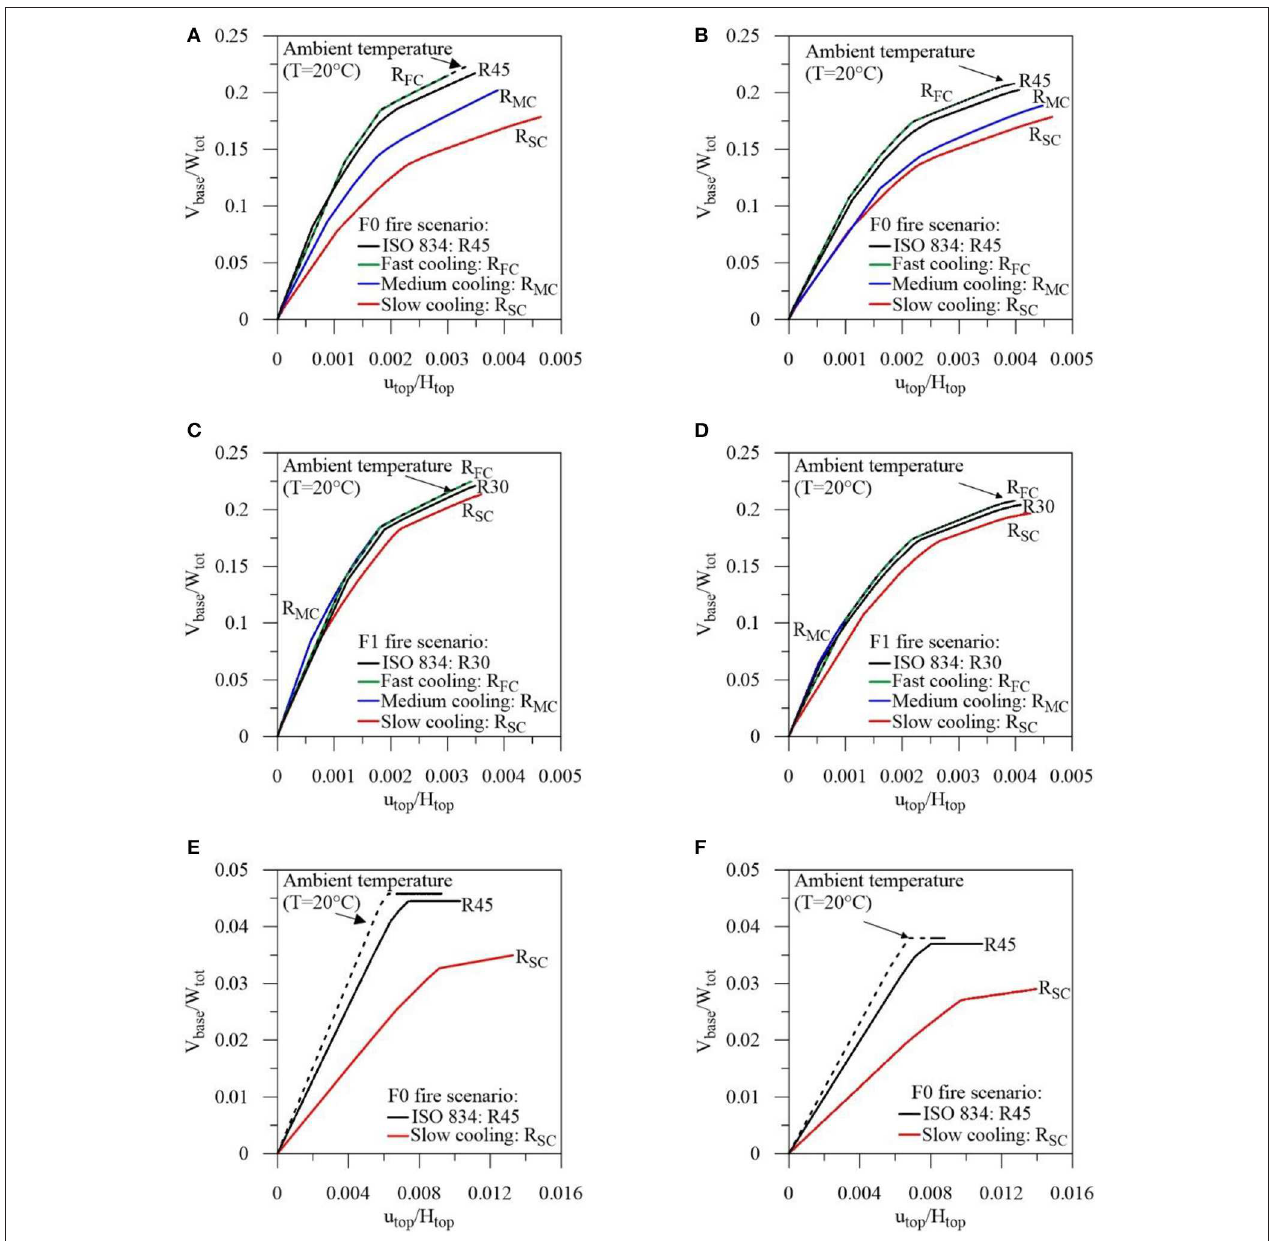
FIGURE 9 | Comparison of pushovers curves for the Collina-Castello school before retrofitting, with and without fire at ground (F0) and first (F1) level. (A) Uniform pattern in the X direction: F0 scenario. (B) Modal pattern in the X direction: F0 scenario. (C) Uniform pattern in the X direction: F1 scenario. (D) Modal pattern in the X direction: F1 scenario. (E) Uniform pattern in the Y direction: F0 scenario. (F) Modal pattern in the Y direction: F0